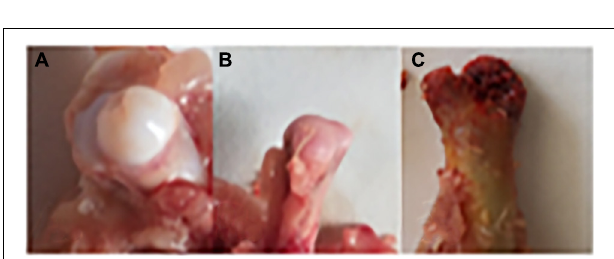
FIGURE 3 | Clinical and anatomical manifestations of FHN broilers. (A) Normal broilers; (B,C) FHN-affected broilers. Panel (B) shows a cartilage loss, and the subchondral bone had ivory-like changes; Panel (C) indicates a cartilage separation, and the epiphysis is